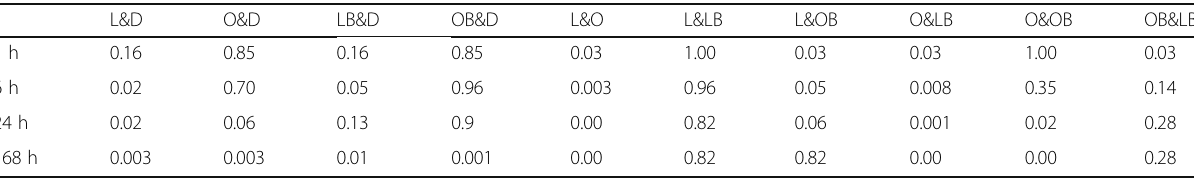
Table 3 Release of chromium ions from SS wires at various time points